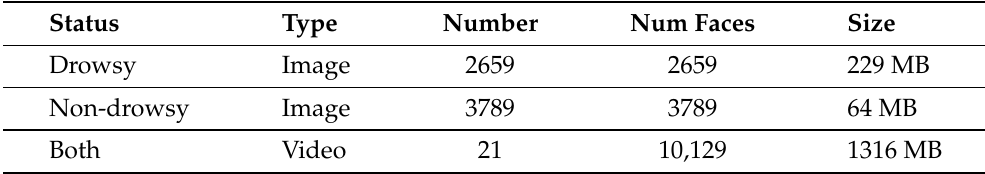
Table 2. Experimental datasets.